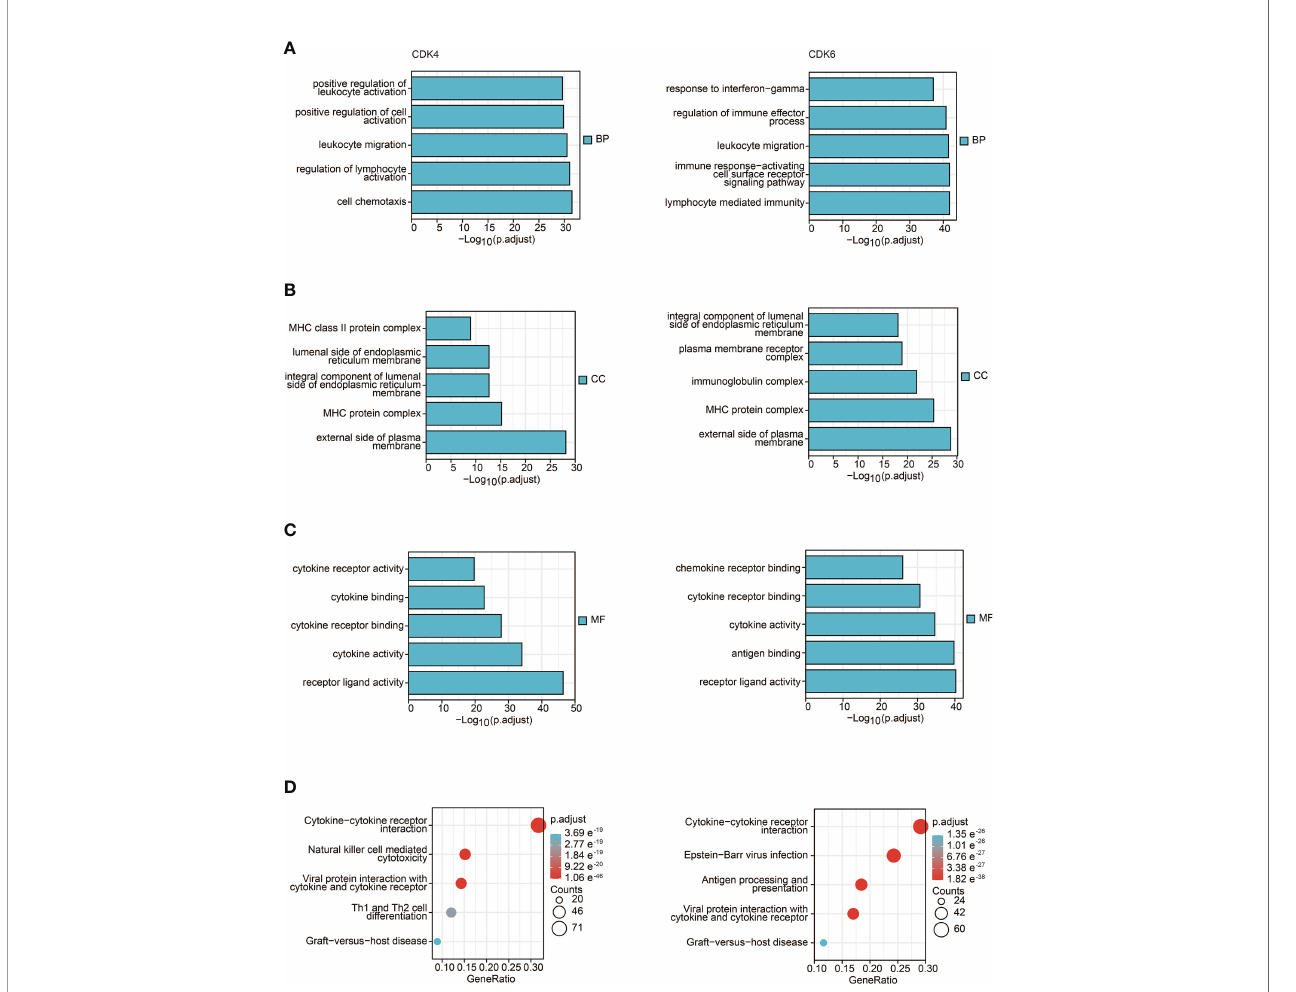
FIGURE 2 | GO and KEGG enrichment pathway analysis. (A) Top 5 of biological process enrichment related to CDK4/6 related genes with bar graph. (B) Top 5 of cell component enrichment related to CDK4/6 related genes with bar graph. (C) Top 5 of molecular function enrichment related to CDK4/6 related genes with bar graph. (D) Top 5 of KEGG pathway enrichment related to CDK4/6 related genes with bar